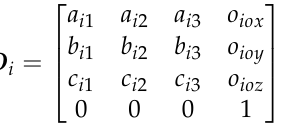
Figure 7. Procedure for obtaining the EE